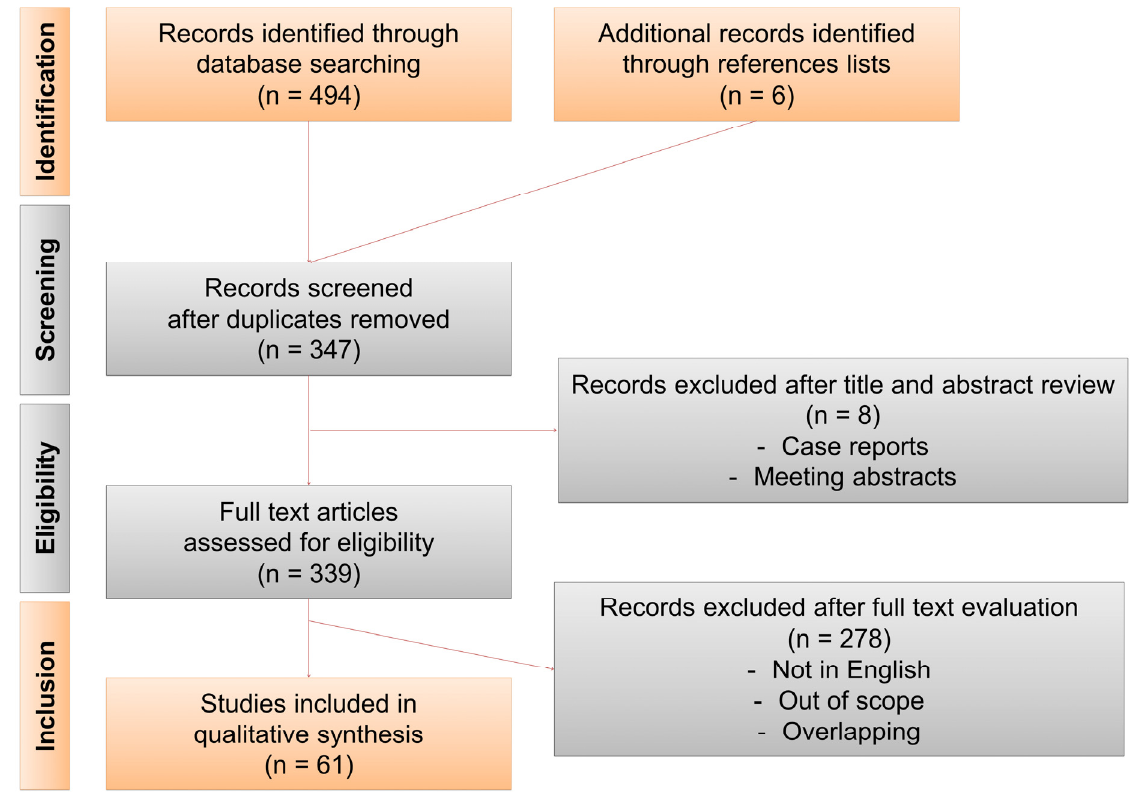
Figure 1. PRISMA flow diagram .